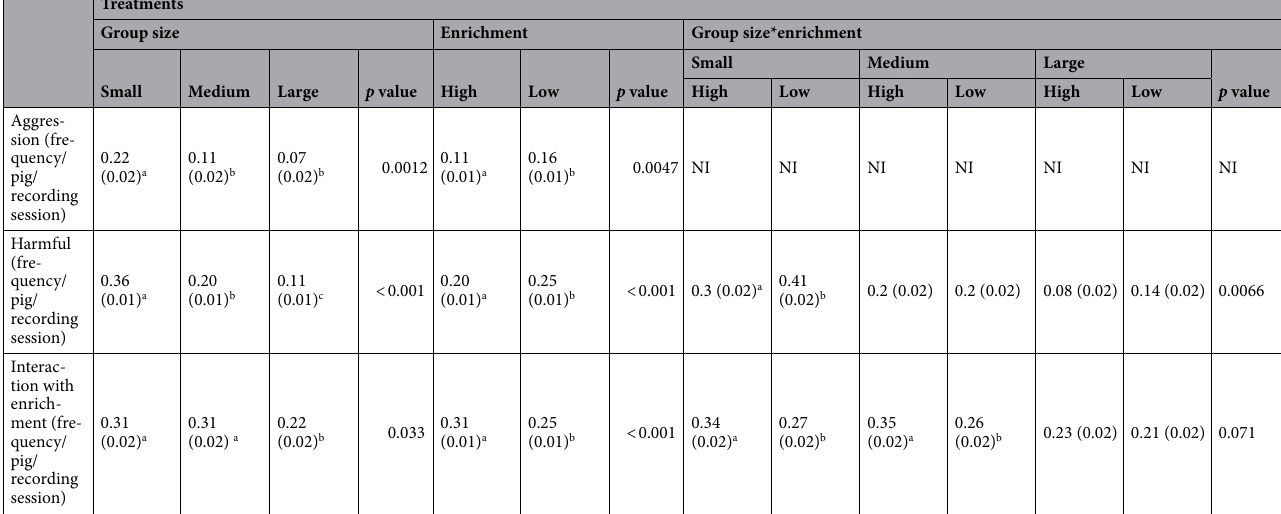
Table 3. LS means (SEM) of the effect of group size and enrichment on the average number of occurrences of aggressive, harmful, interaction with enrichment behaviours performed per 5-min observation of pens of pigs. Group size: Large (48 pigs/pen), Medium (24 pigs/pen), Small (12 pigs/pen), Enrichment: Low (Wood + Hanging toy), High (Wood + Hanging toy + Grass). NI Not included in the final model p > 0.10. abc Different letters denote significant differences picked up by Tukey–Kramer test ( p < 0.05).